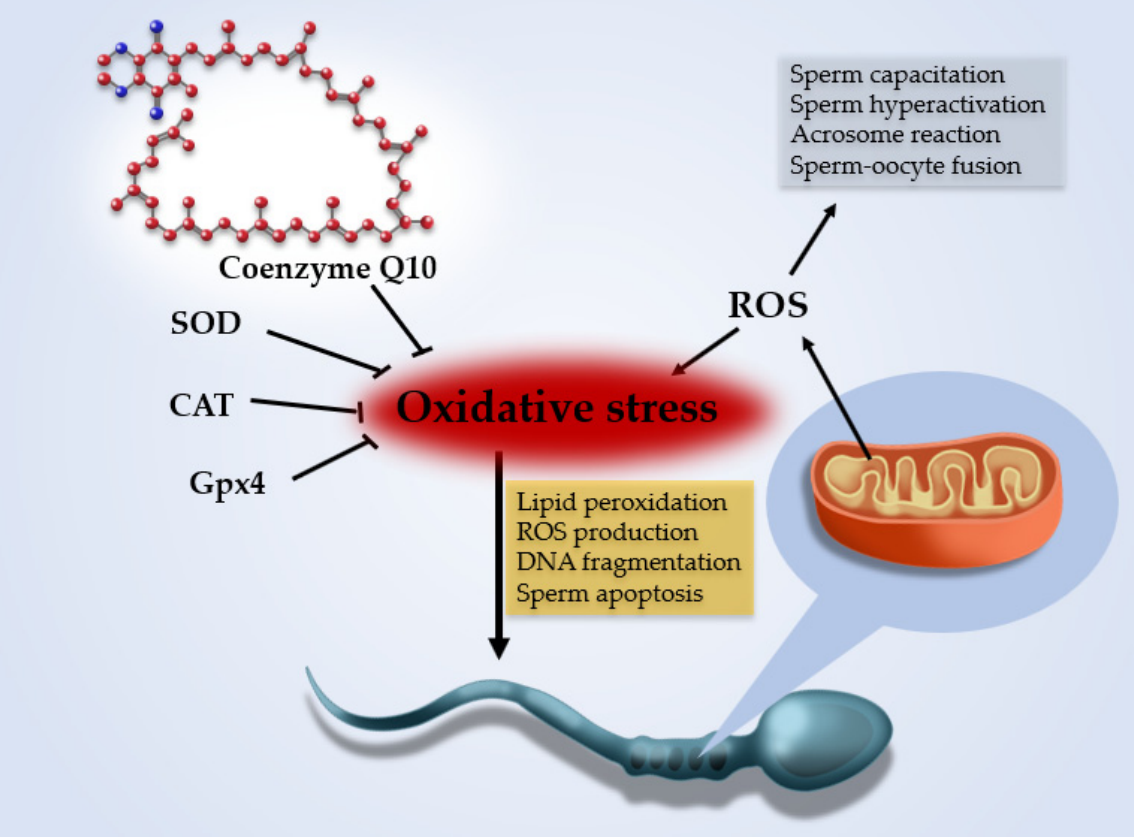
Figure 1. Reactive oxygen species (ROS) are oxygen-derived free radicals produced by oxidative metabolic pathways (chiefly the mitochondrial respiratory chain). Small amounts of ROS are needed to ensure normal sperm cell functions such as capacitation, hyperactivation, acrosome reaction and sperm-oocyte fusion, but excess ROS production induces oxidative stress (OS). Seminal fluid and sperm cells are rich in antioxidant molecules (superoxide dismutase -SOD-, catalase -CAT- and glutathione peroxidase 4—Gpx4), which counterbalance the effect of ROS. Spermatozoa are susceptible to OS because their plasma membrane is rich in polyunsaturated fatty acids that undergo lipid peroxidation, which in turn increases ROS production and induces DNA fragmentation and sperm apoptosis. Coenzyme Q10 is an obligatory co-factor with strong antioxidant properties that counteract OS by reducing ROS production in mitochondria and protect spermatozoa membranes from lipid peroxidation.